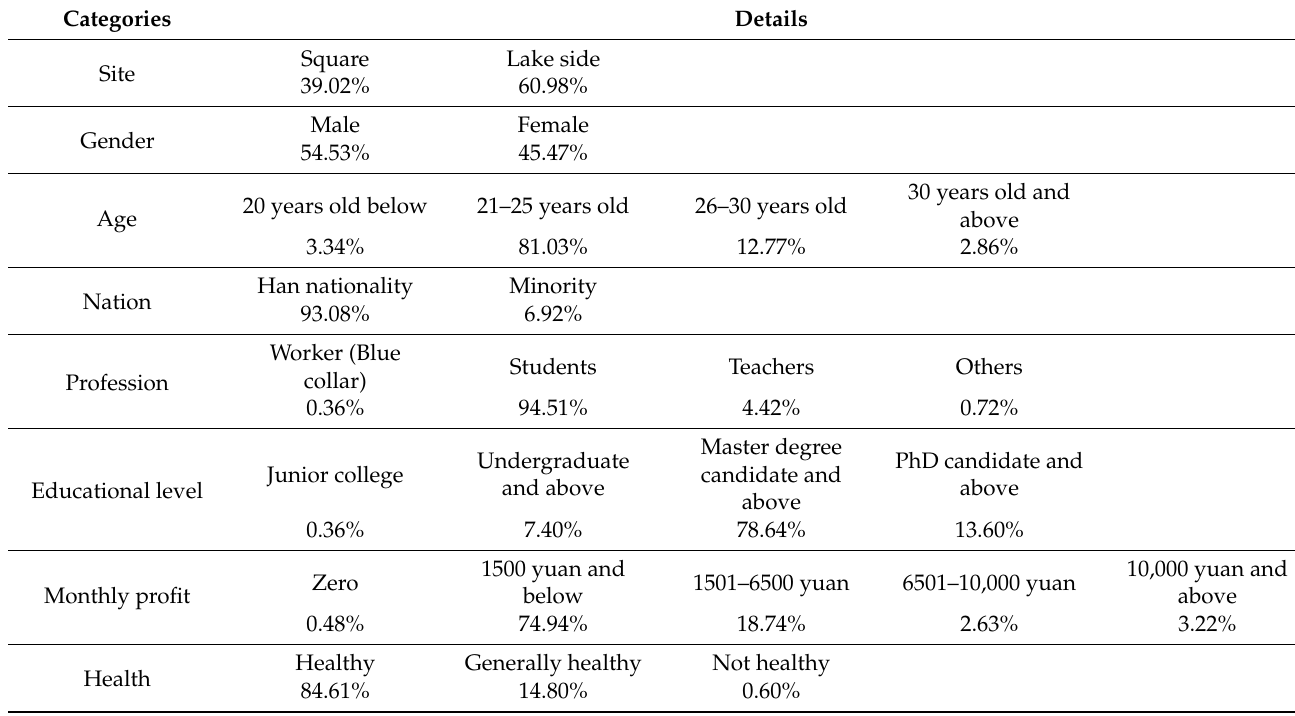
Table 2. Basic Information of the